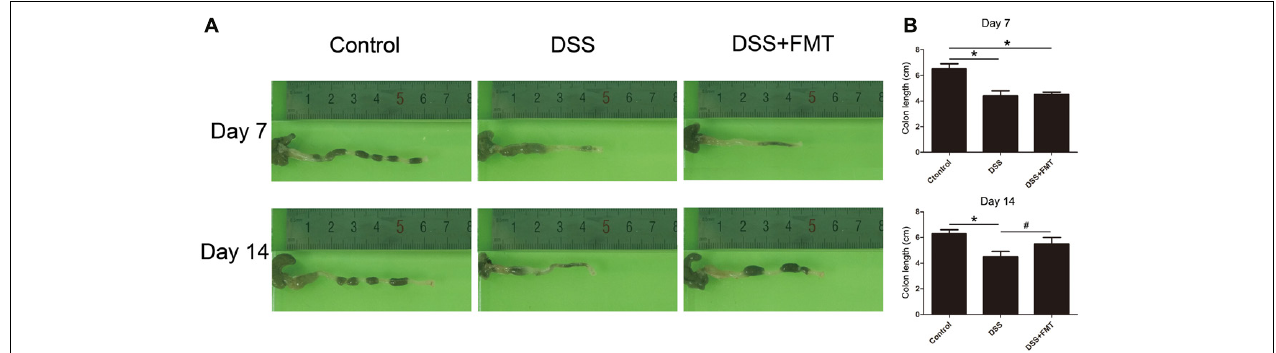
FIGURE 2 | Fecal microbiota transplantation prevented DSS-induced shortening of colon length. Colon length in each group was measured at day 7 and day 14 of the experiment. (A) Representative colon images at the indicated time point in each group. (B) Data are shown as the mean ± SD ( n = 3 mice per group). ∗ p < 0.05 compared to the control group. # p < 0.05 compared to the DSS group.